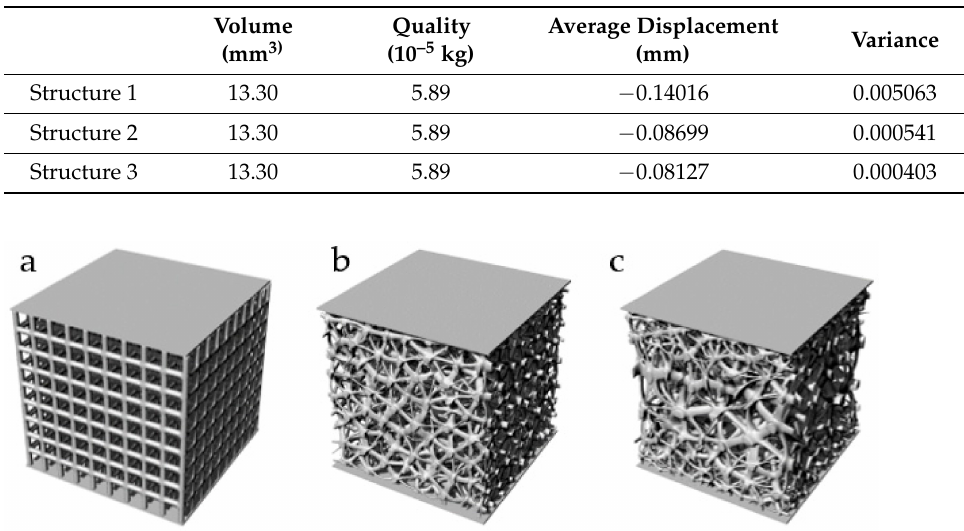
Figure 26. Ti6Al4V structures with target porosity and target average pore radius made by SLM. ( a ) Structure with P = 40%, r = 0.3 mm; ( b ) Structure with P = 40%, r = 0.5 mm; ( c ) Structure with P = 50%, r = 0.5 mm; ( d ) Structure with P = 60%, r = 0.5 mm. Table 5. Force analysis results.